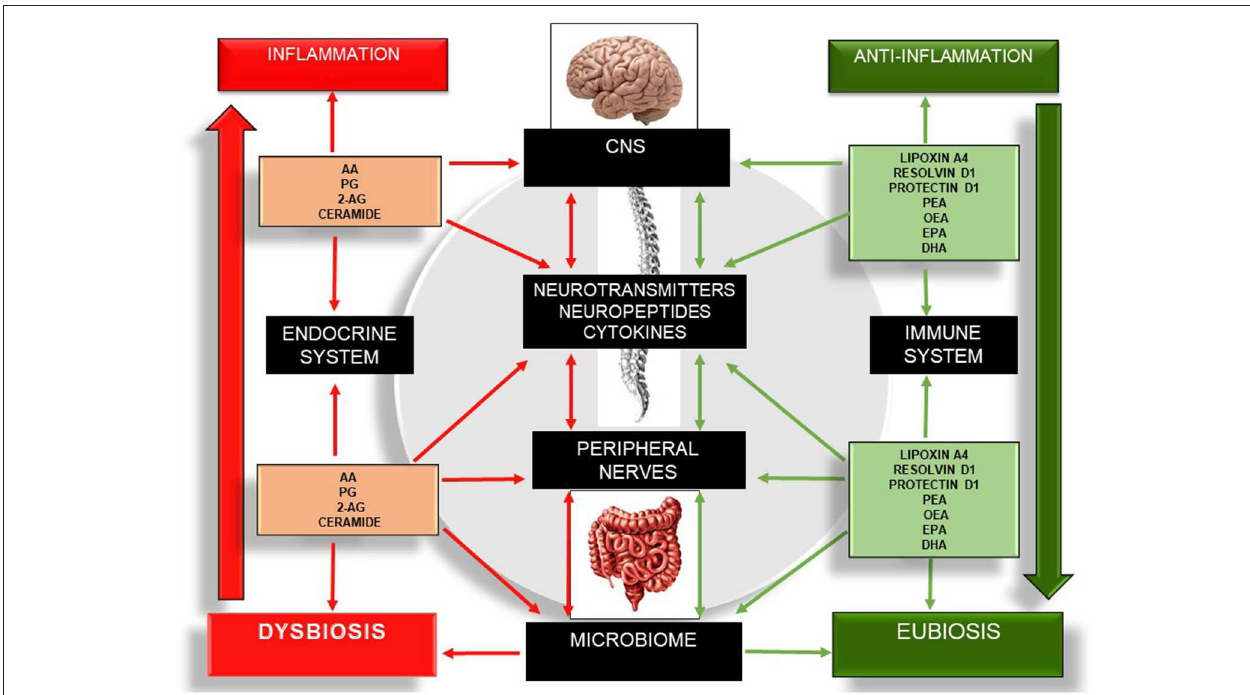
FIGURE 4 | Schematic illustration of the bidirectional communication network involving the gut–brain axis and the different bioactive lipid members, as well as their roles in inflammation, the microbiome, and the expression of cytokines, neuropeptides, and neurotransmitters. Red arrows indicate pro-inflammation. Green arrows indicate anti-inflammation. The left side of the figure describes the pro-inflammatory actions of several bioactive lipids, which in turn drive a sustained net of inflammatory processes, increasing neuroinflammation, neurodegeneration, dysbiosis, and enteric and skeletal muscle tissue damage. The right side of the figure describes the anti-inflammatory effect of several bioactive lipids and their influences on the central nervous system, peripheral nerves, and microbiome. 2-AG, 2-Arachidonoylglycerol; CNS, Central Nervous System; DHA, Docosahexaenoic Acid; EPA, Eicosapentaenoid Acid; OEA, Oleoilethanolamide; PEA, Palmitoylethanolamine; PG,